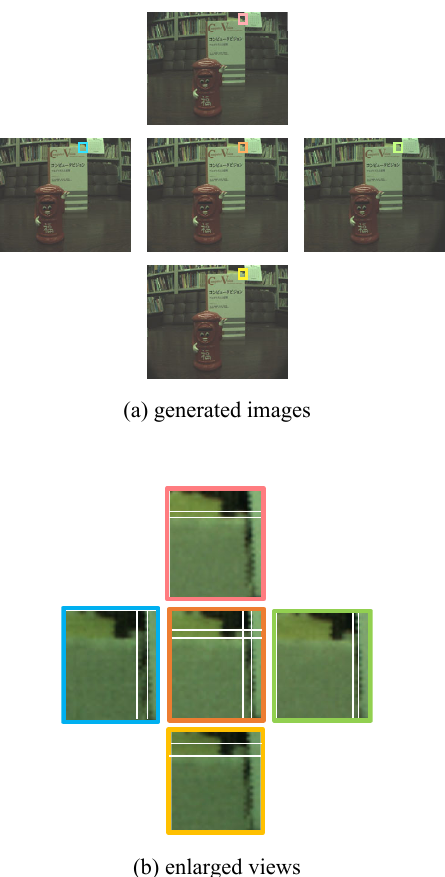
Figure 8. Example of multi-view